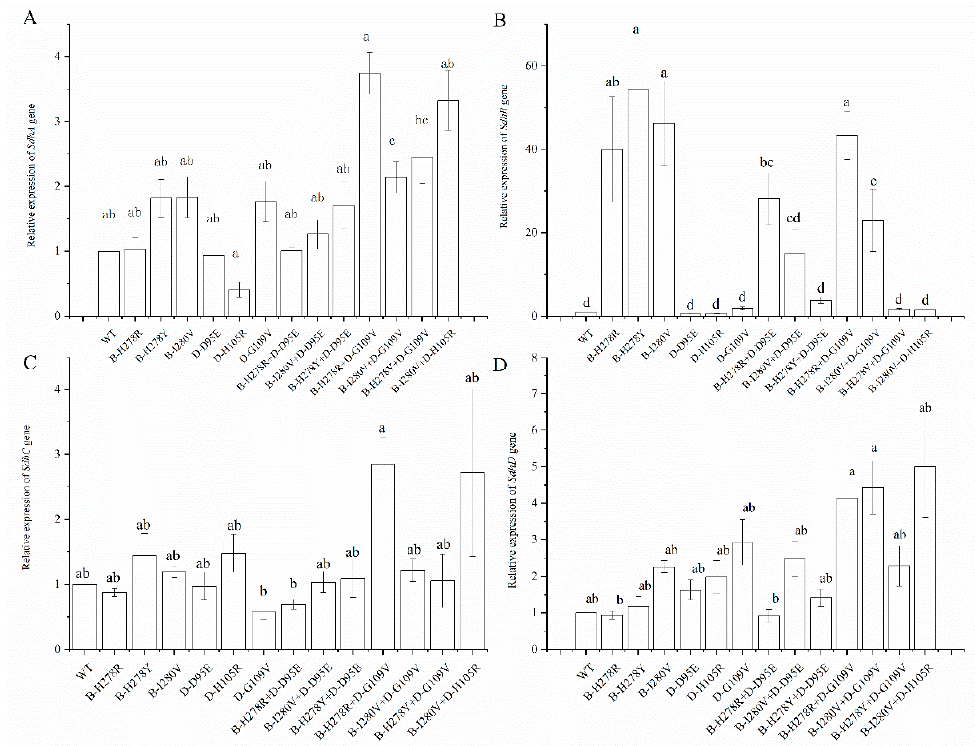
Figure 5. Relative expression levels of the SDHA/B/C/D genes in the double mutation. All data were normalized to EF-1 gene expression, and relative changes in expression were analyzed by the ABI 7500 software. Different letters indicate significant differences ( p < 0.05) ( A ) Expression of SDHA gene. ( B ) Expression of SDHB gene. ( C ) Expression of SDHC gene. ( D ) Expression of SDHD gene.